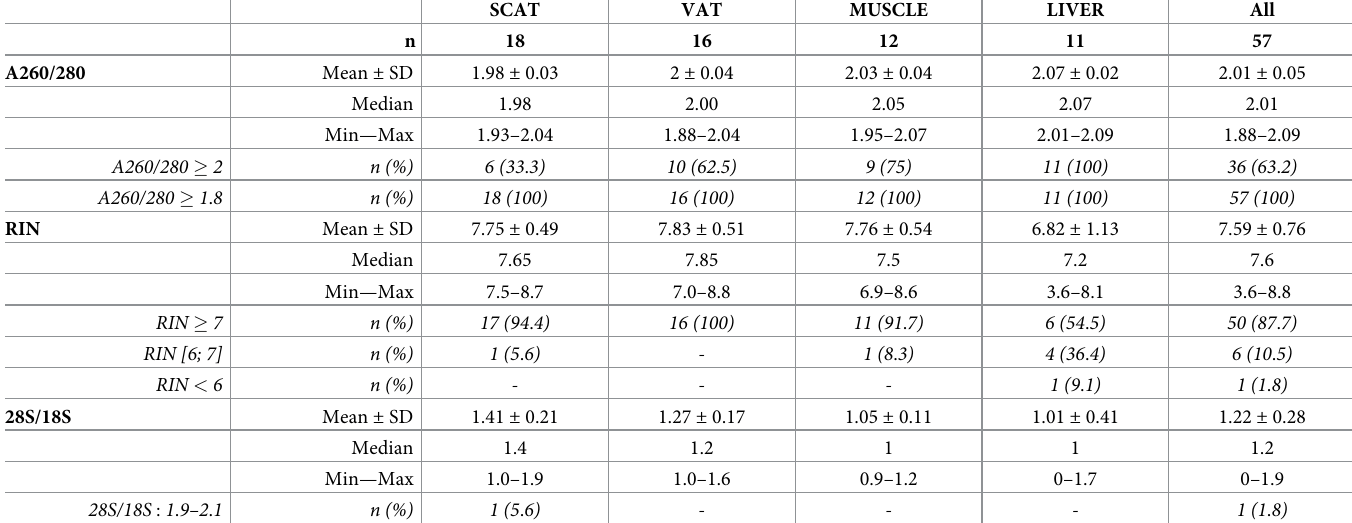
Table 6. Quality metrics of RNA isolated from frozen tissues obtained from the first five patients included. Absorbance at 260 and 280 nm, RIN and 28S/18S ratio were assessed for each RNA sample isolated from frozen SCAT, VAT, muscle, and liver. Mean ± SD, median, and ranges for each type of RNA are shown. The number of samples (and percentage) in the optimal value of purity (A260/280 � 2) and integrity (RIN � 7, 28S/18S ratio: 1.9–2.1) is also presented.